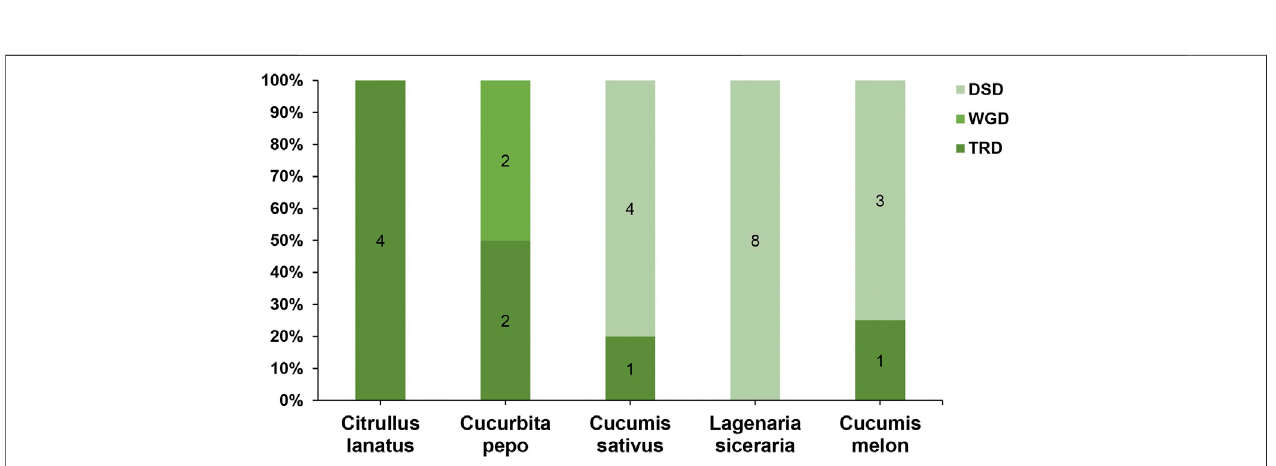
FIGURE 6 | Comparison of gene duplication events in fi ve Cucurbitaceae genomes. WGD, whole-genome duplicates; TRD, transposed duplicates; DSD, dispersed duplicates.